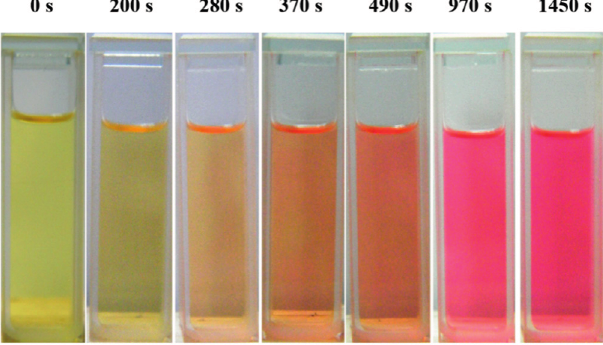
Figure 13. Color change of the hyperbranched poly( ε -caprolactone) (HPCL, M n GPC = 25,500 g/mol, M w / M n = 2.38) during the irradiation with 365 nm UV light in chloroform solution (The concentration of azobenzene moieties is 5.00 × 10 − 5 M at room temperature). The corresponding photoisomerization kinetics of BHA, P1 and HPCL in chloroform solution was plotted in Figure 14. The rate of trans-cis photoisomerization was analyzed from the absorption of 403